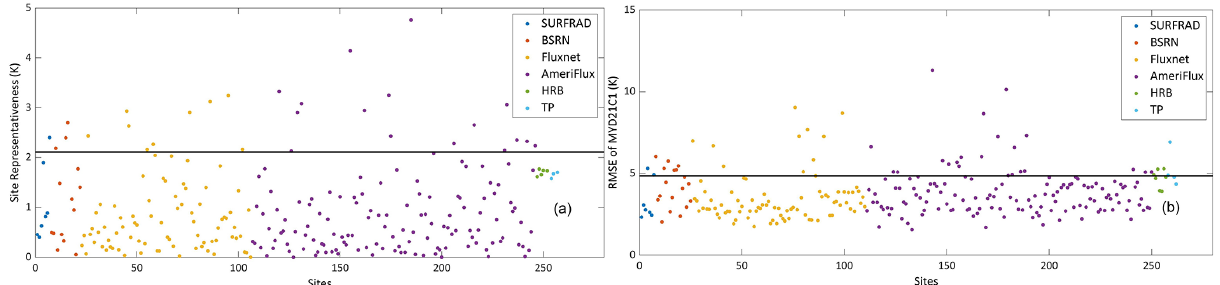
Figure 1. LST site selection results based on the (a) site representativeness calculated by Landsat samples and (b) site RMSEs of MYD21C1. The thresholds are the black lines, and sites with RMSEs higher than the line were masked out. The abbreviations used in the figure are as follows: SURFRAD – Surface Radiation Budget, BSRN – Baseline Surface Radiation Network, HRB – Heihe River basin (HRB), and TP – Tibetan Plateau.